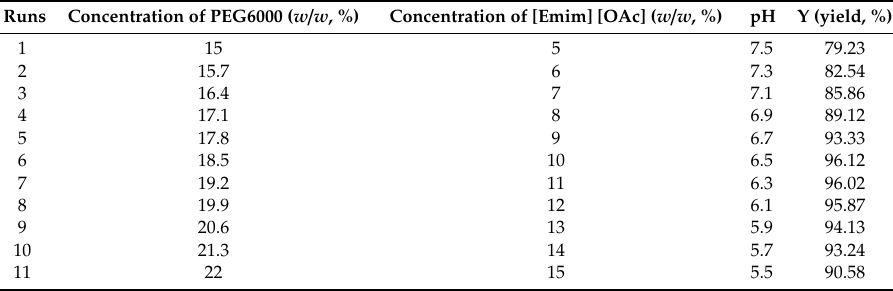
Table 3. The detailed design and results of the ascent